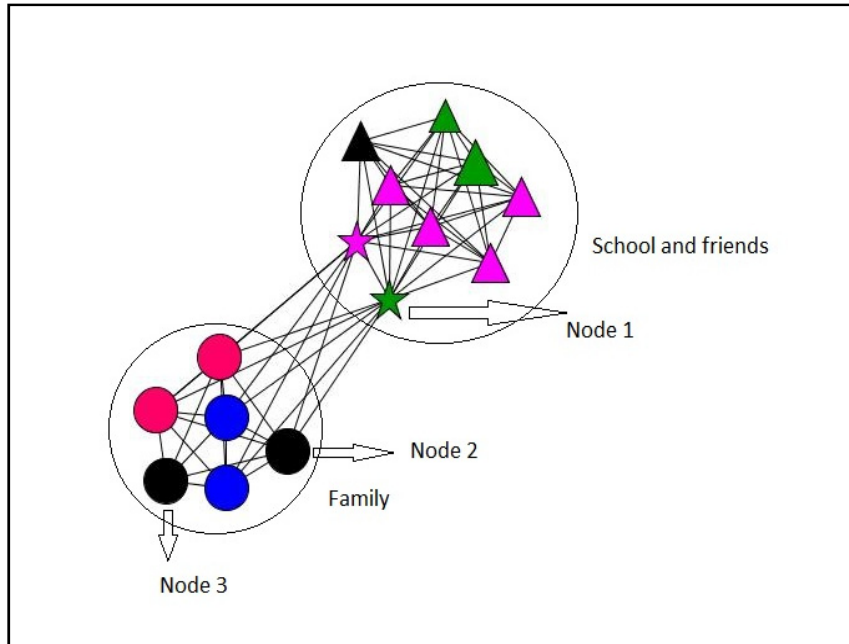
Figure 5. Case 3. Girl. 17 years old. School group.